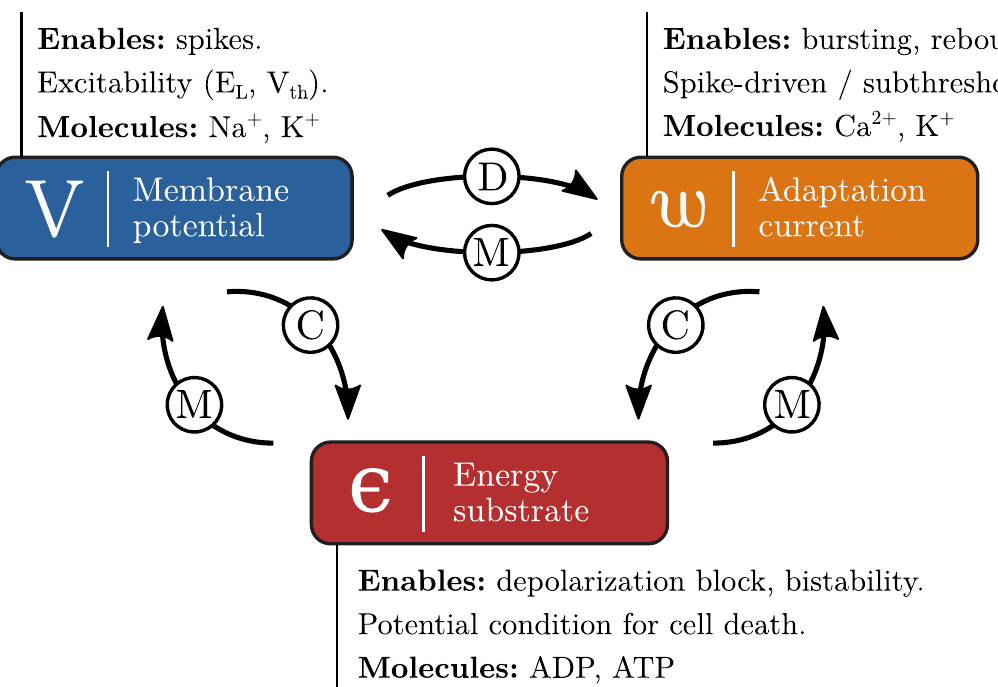
Fig 1. Variables and interactions that must be present in the models to capture all relevant behaviors, the main molecules associated to each of the variables are also displayed. The type of interaction is marked on the arrow. For instance, w modulates (M) V as it influences the intrinsic dynamics of V but does not usually cause it directly. On the other hand, as changes in the membrane potential are the main cause of variations in w , V is said to drive (D) w . Eventually, all mechanisms consume (C)